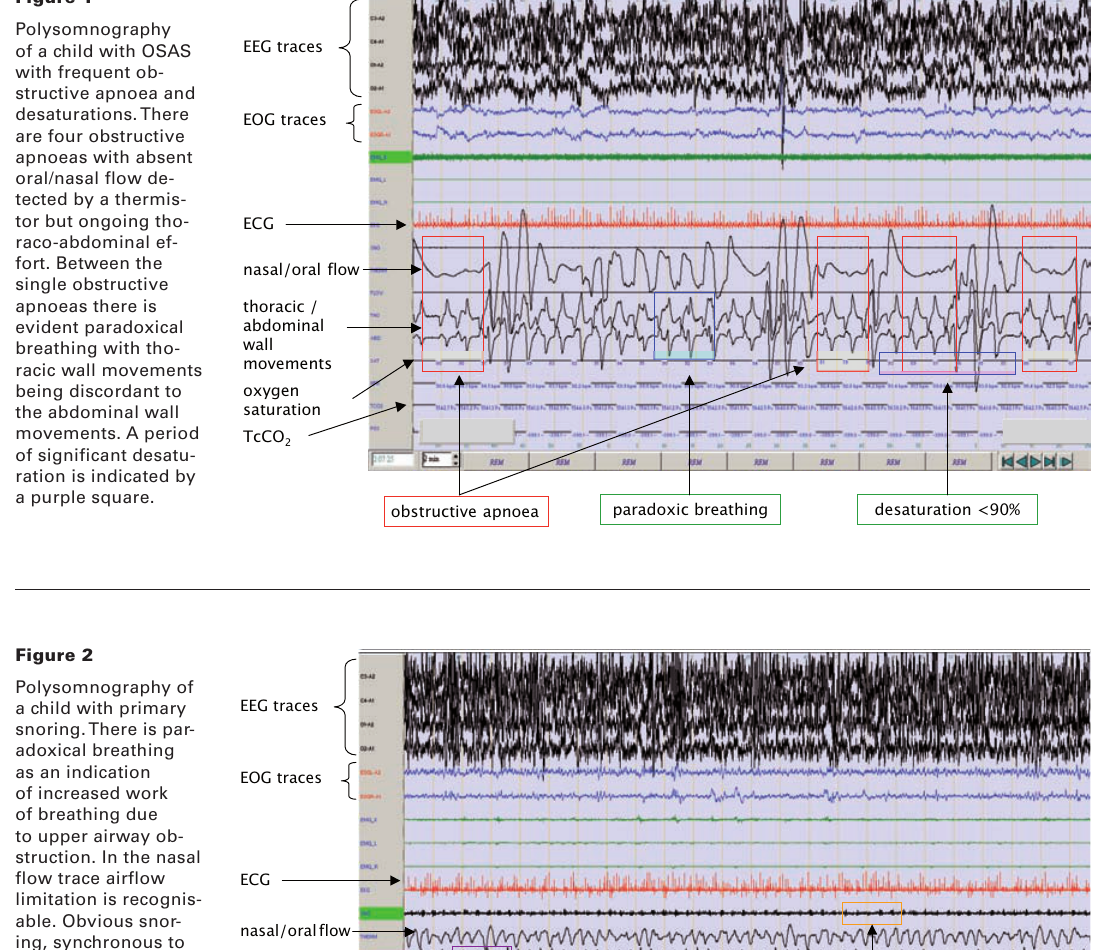
Figure 3 Polysomnography of a child with upper airway resistance syndrome with fre- quent arousals. There is continuing para- doxical breathing and low oxygen satura- tions between 76–88%. Transcuta- neous CO 2 is elevated with values around 6.2–6.3 kPa. Two arousal episodes are